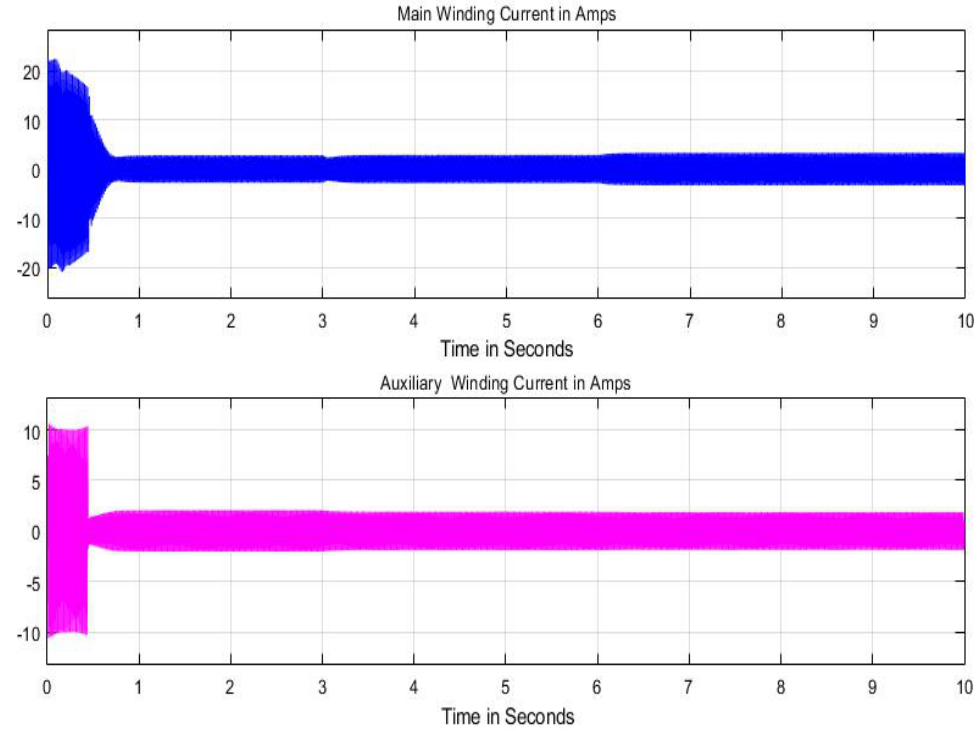
Figure 17. Current variations for various load torque. The main winding current is zoomed and it is shown in Figure 18.